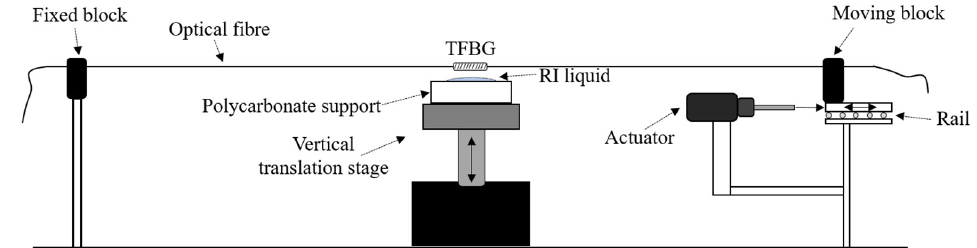
Figure 3. Schematic of the experimental setup dedicated to the strain effect investigation.